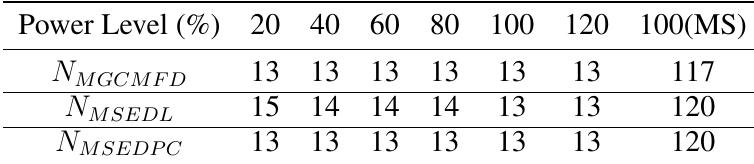
Table 5: Total Number of Outer Iterations for Problem 4